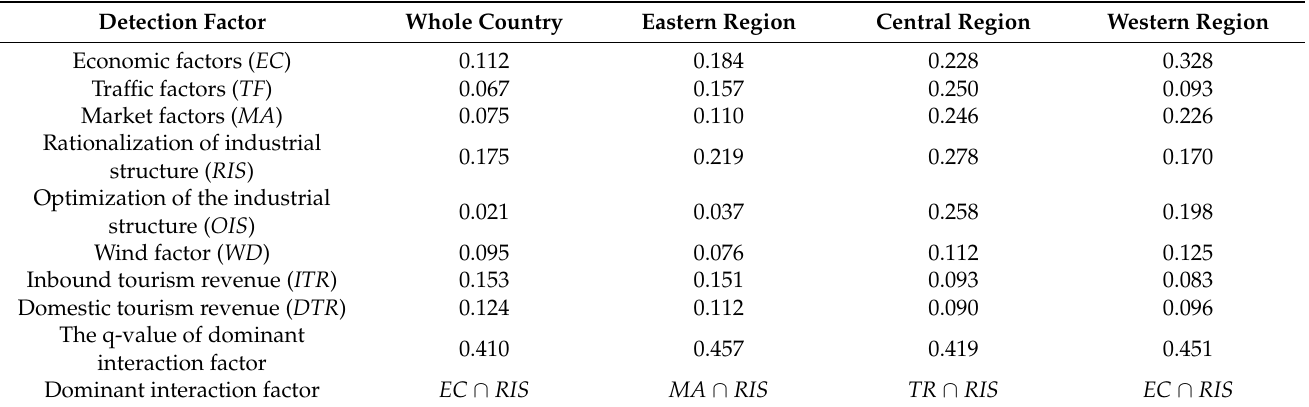
Table 7. Exploration results of influencing factors of air